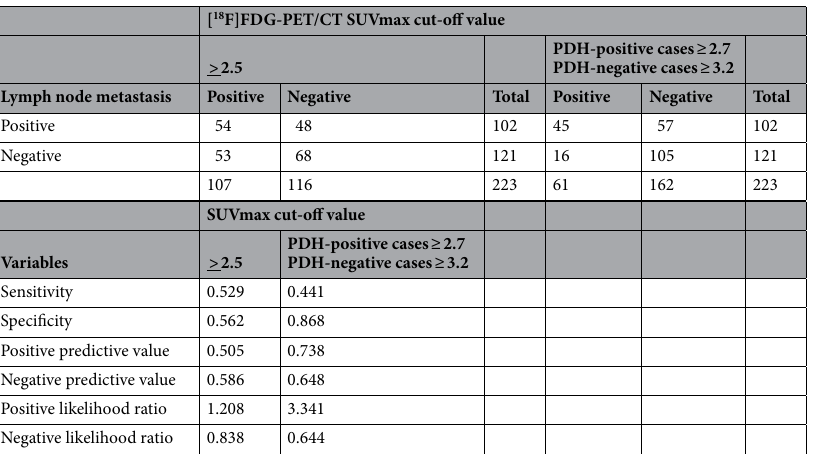
Table 3. Comparison of sensitivity, specificity, predictive value, and likelihood ratio of [ 18 F]FDG-PET/CT between the conventional SUVmax cut-off and PDH-followed SUVmax cut-off. [ 18 F]FDG-PET/CT, [ 18 F] fluorodeoxyglucose positron emission tomography/computed tomography; SUVmax, maximum standardized uptake value; PDH, pyruvate dehydrogenase. SUVmax, maximum standardized uptake value; PDH, pyruvate